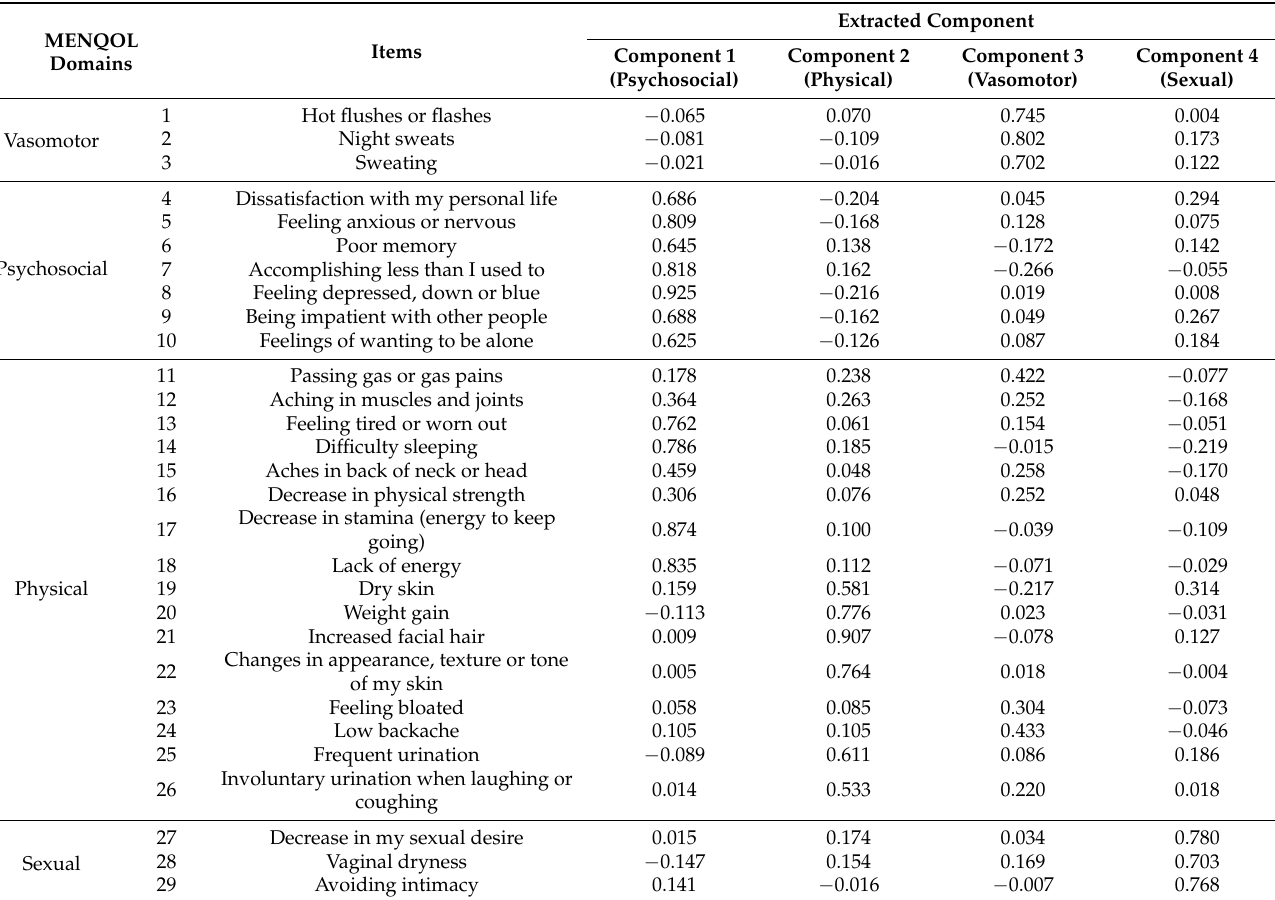
Table 2. Factor structure of the Polish version of the MENQOL scale.